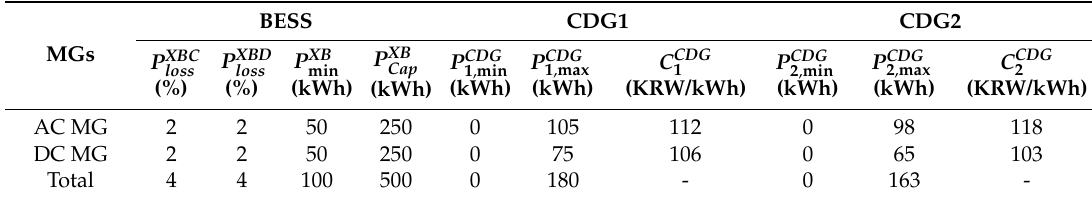
Table 2. Parameters related to controllable distributed generators (CDGs) and BESS units of the hybrid